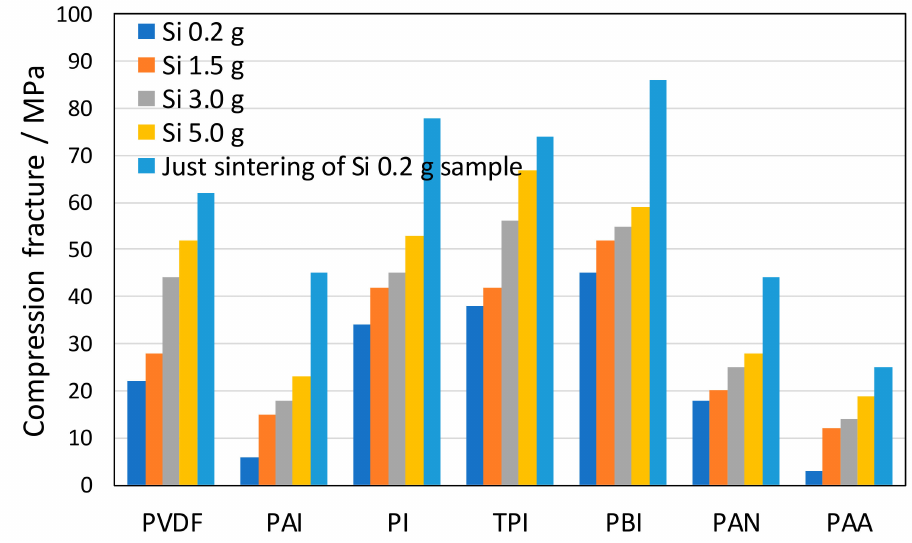
Figure 5. Dependence of compression